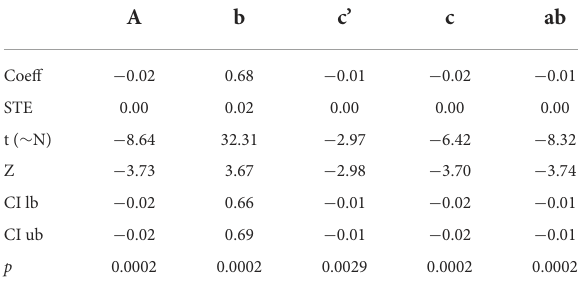
TABLE 3 Coefficient, standard error, t value, Z score, 95% confidence interval, and associated p -value outputted from the mediation